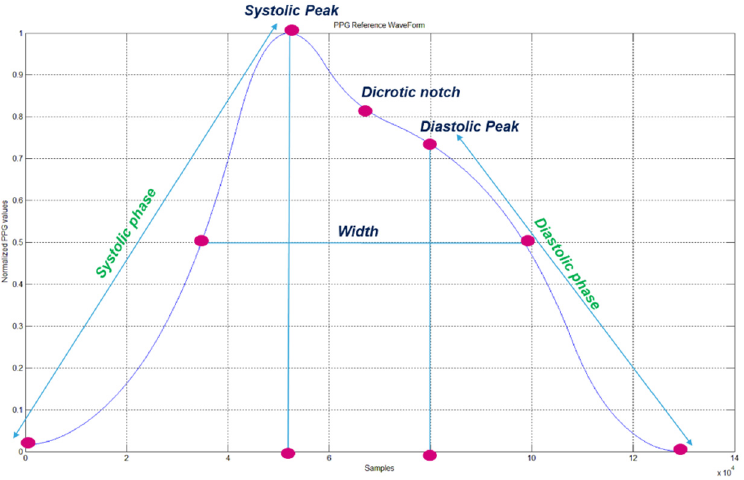
Figure 1. Compliant standard PhotoPlethysmoGraphic (PPG) signal pattern.